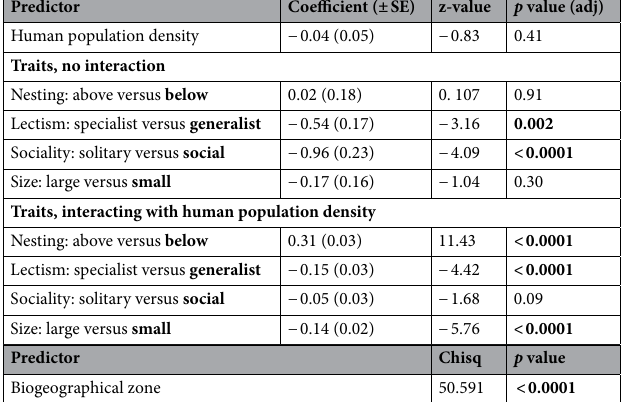
Table 3. Summary of the traits-density model. p values in bold are significant (α = 5%). The significance of the categorical variable “Biogeographical zone” was evaluated using a Likelihood Ratio Test. This model is a mixed-effect model, the random variables included are the sites ID, nested in the sampling categories, as well as the species names. Coefficients are given with their standard error. Traits in bold are the reference modalities. p value(adj) means that p-values were adjusted with the False Discovery Rate adjustment method.